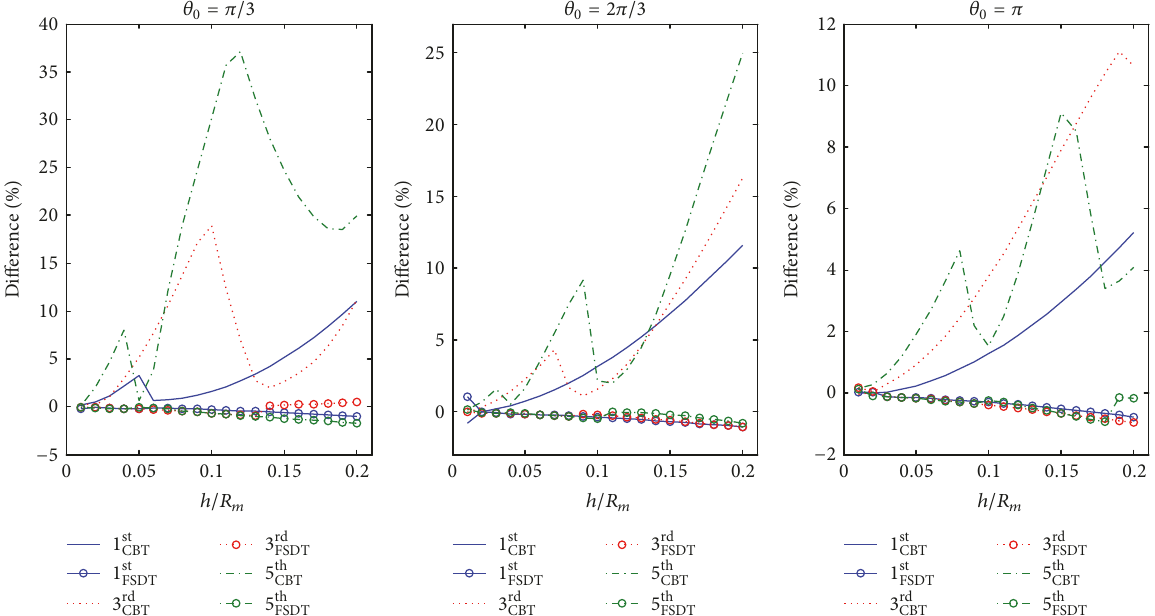
Figure 5: Relative deviations between frequency parameters Ω based on the CBT/FSDT theory models to those of 2D theory for circular beams with different thickness-to-radius ratios (C-C boundary